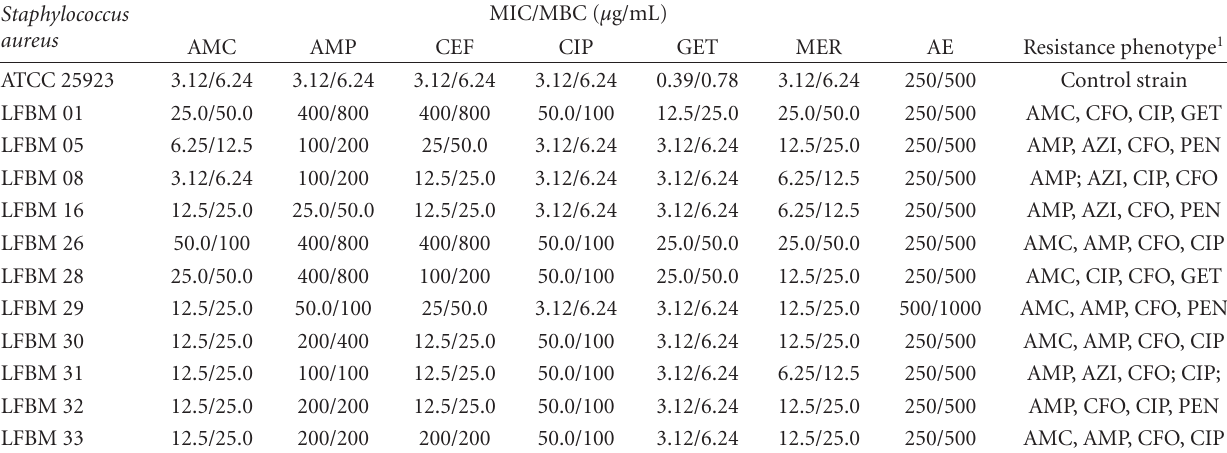
Table 1: MIC/MBC of the aqueous extract of Psidium guineense and antimicrobial agents against MRSA strains. Staphylococcus